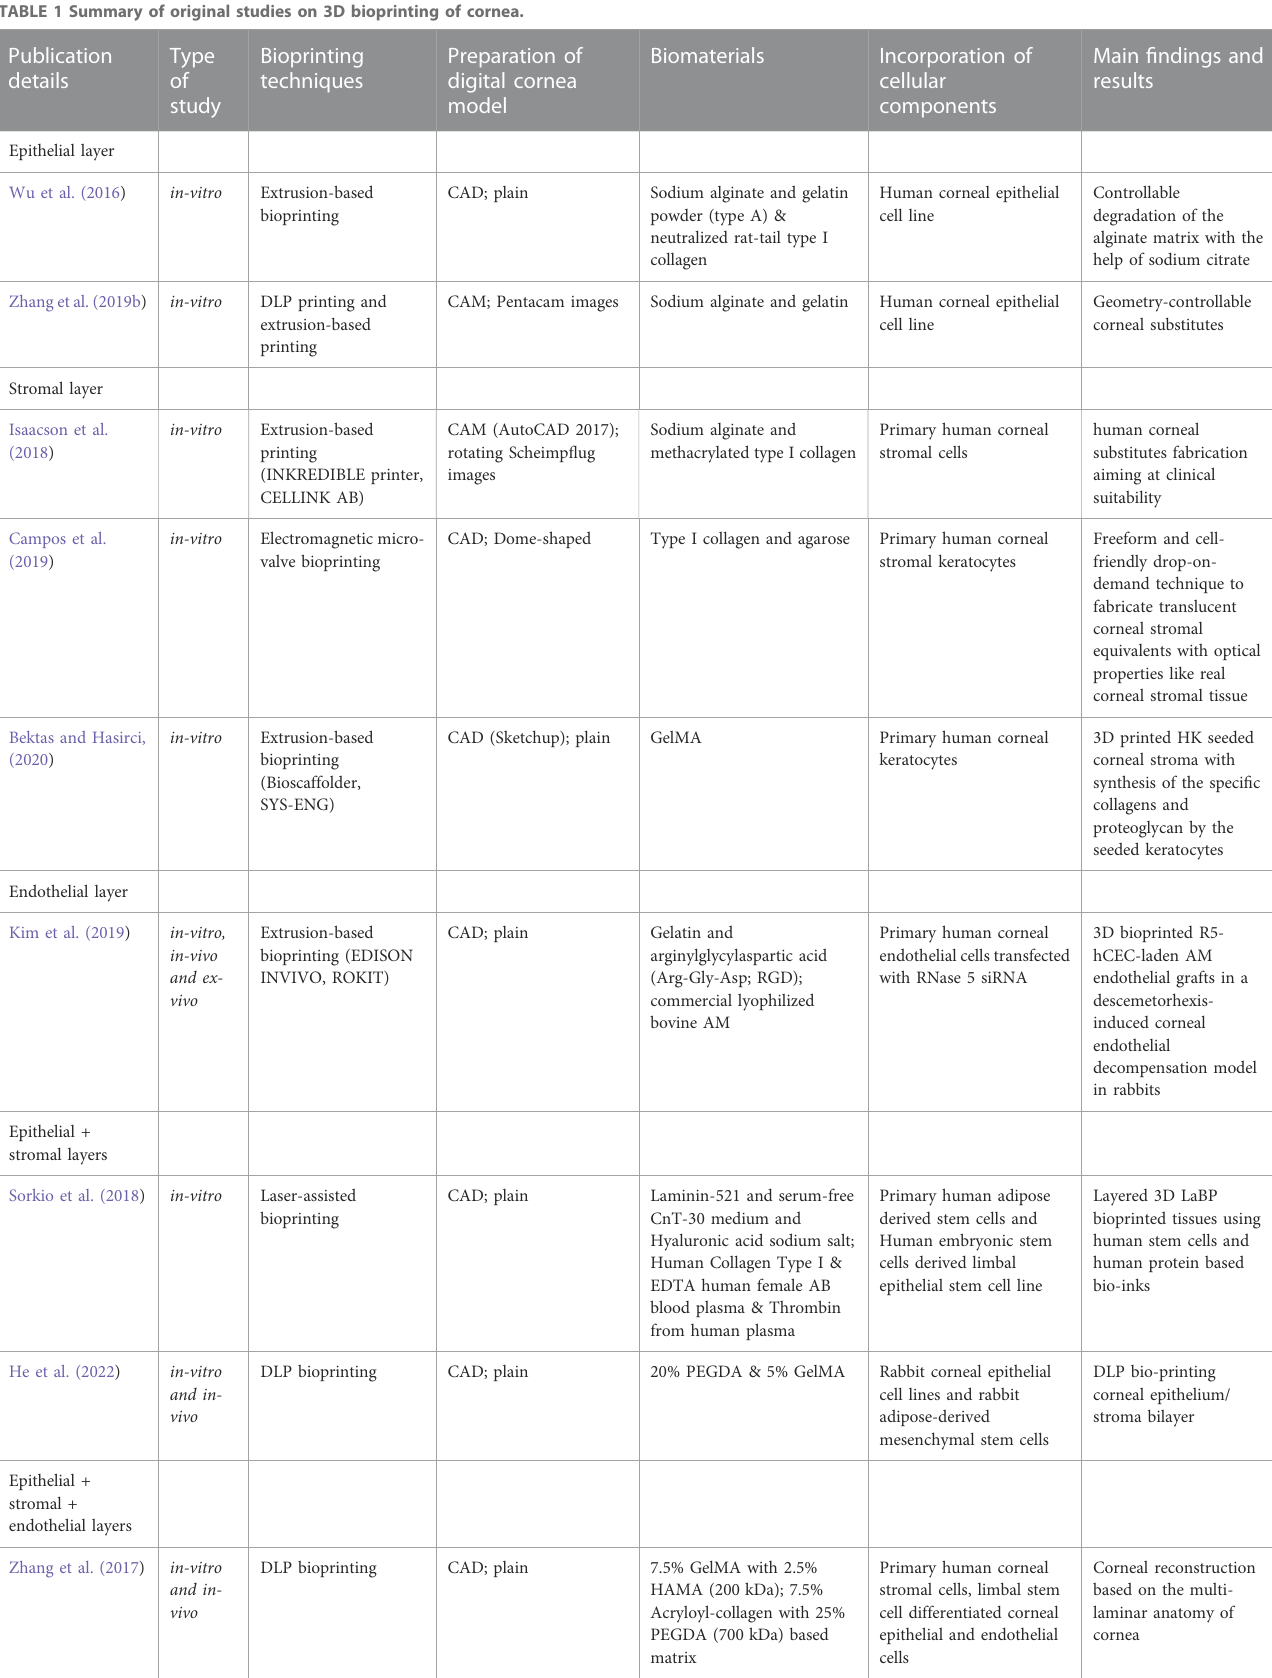
TABLE 1 Summary of original studies on 3D bioprinting of